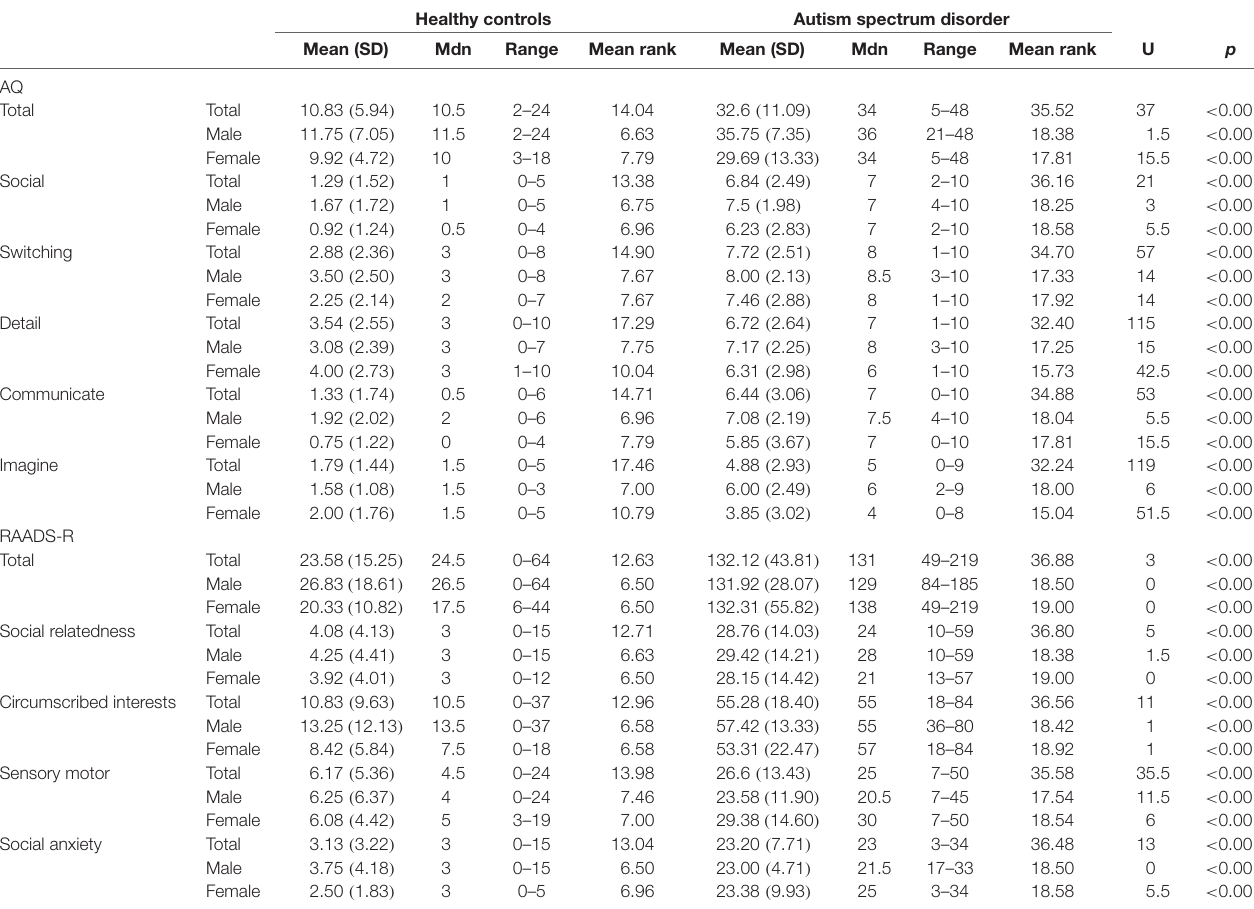
TABLE 2 | Summary of self-reported traits and characteristics associated with autism spectrum